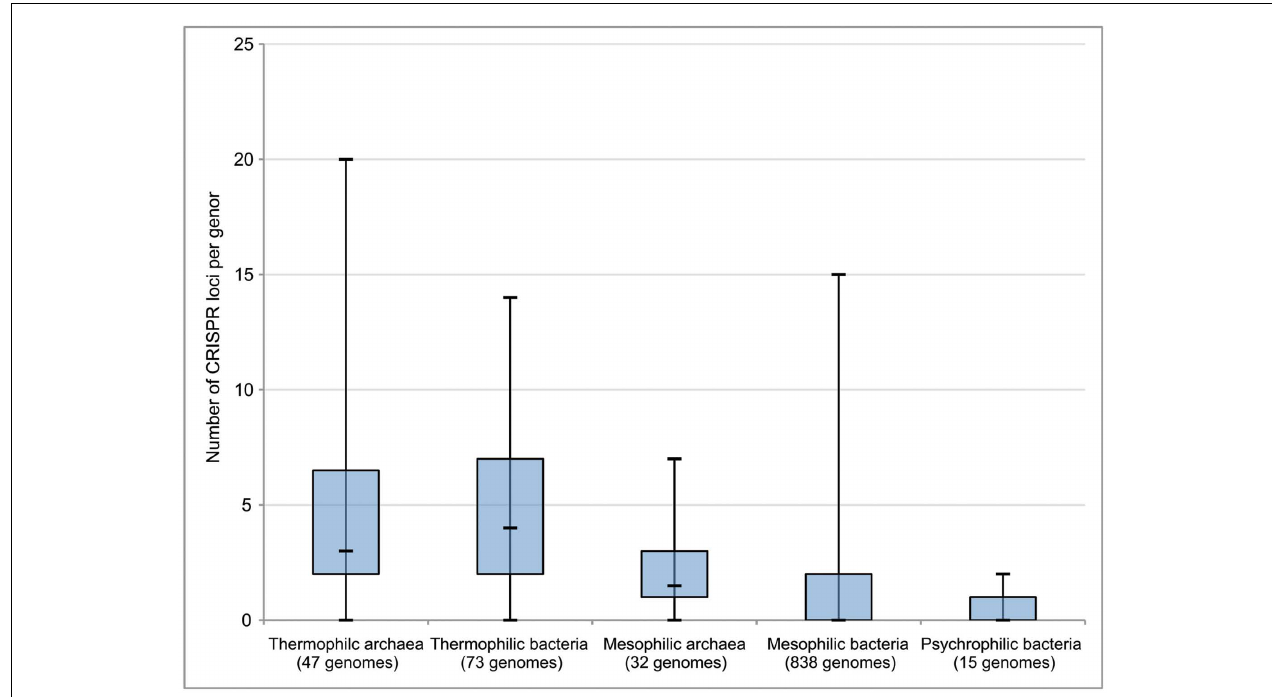
FIGURE 2 | Number of CRISPR loci per genome in thermophilic, mesophilic, and psychrophilic archaea and bacteria. Box boundaries represent first and third quartiles, and markers on lines represent minimum, median, and maximum, respectively. Modified from Anderson et al.